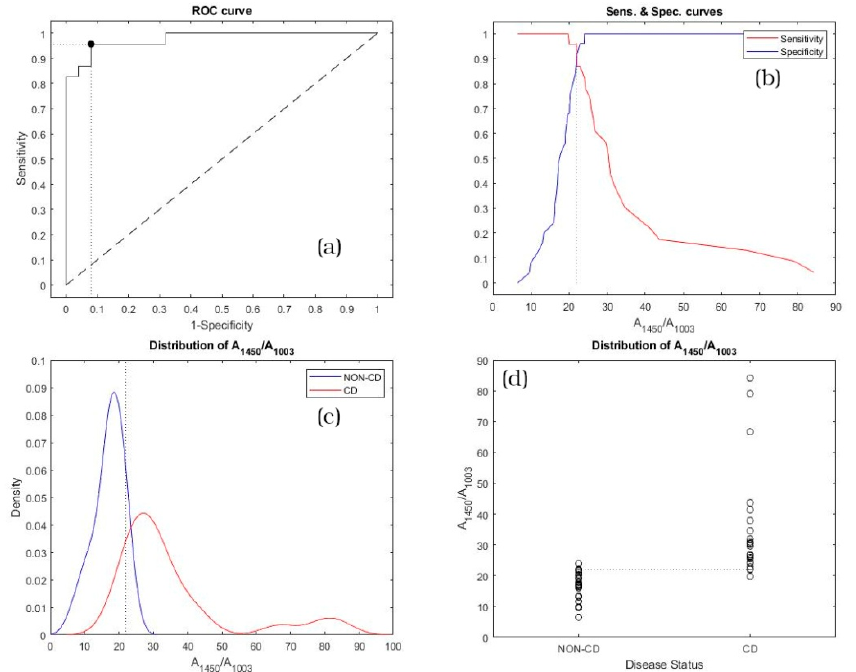
Figure 4. Statistical analysis related to the A 1450 /A 1003 ratio for non-CD and CD subjects: ( a ) ROC curve; ( b ) sensitivity and specificity vs. A 1450 /A 1003 ratios; ( c ) kernel distribution fit and ( d ) scatter distribution.